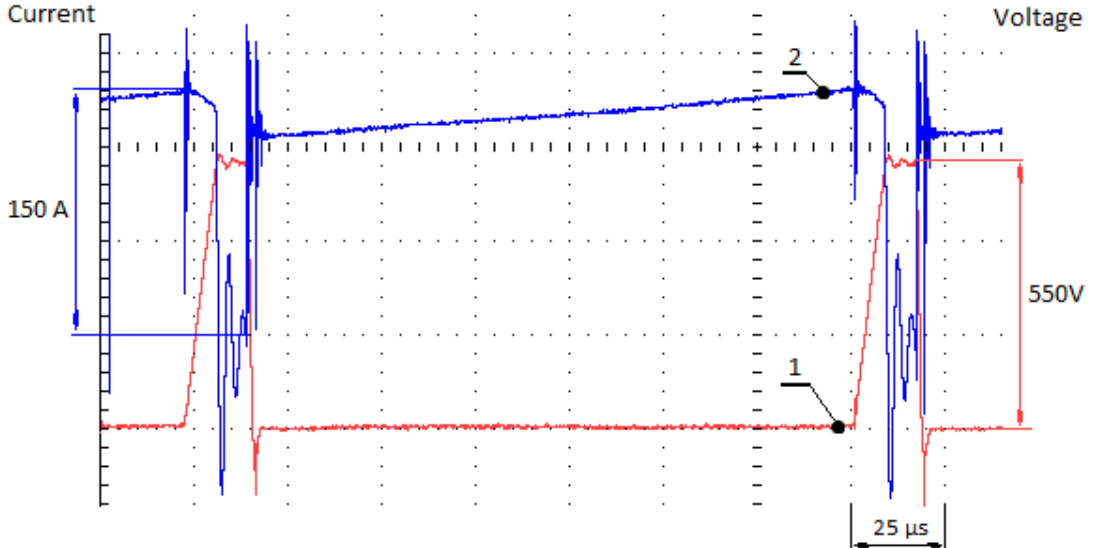
Figure 13. Buck mode of operation. 1–voltage gate-to-source Q1 (module M1), 2–current through transistors Q1. Duty cycle over 0.95.